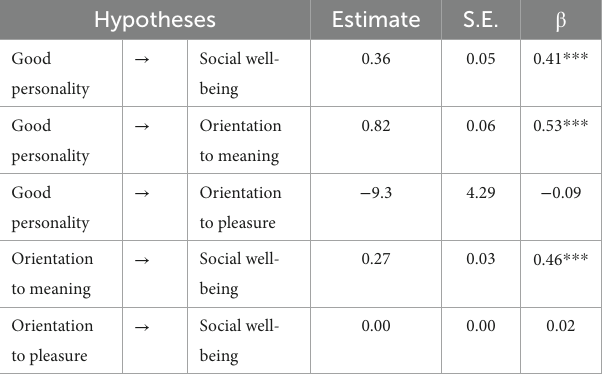
TABLE 2 Model SEM